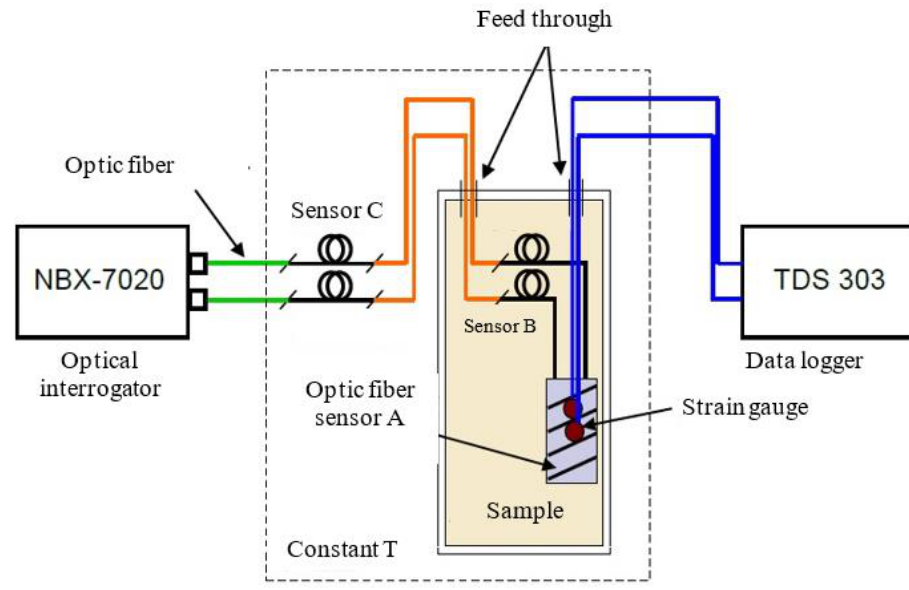
Figure 3. A schematic diagram of the experimental setup.